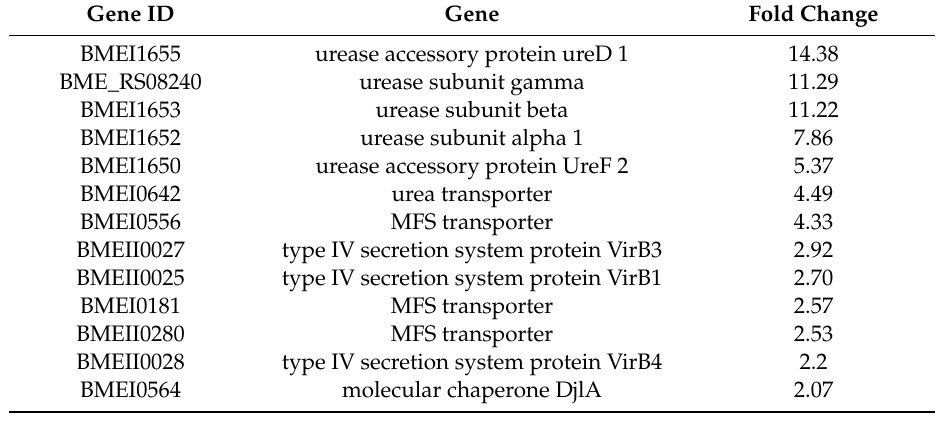
Table 1. Key genes potentially involved in the response of B. melitensis 16M to acidic stress (false discovery rate (FDR) < 0.001 for all listed genes).